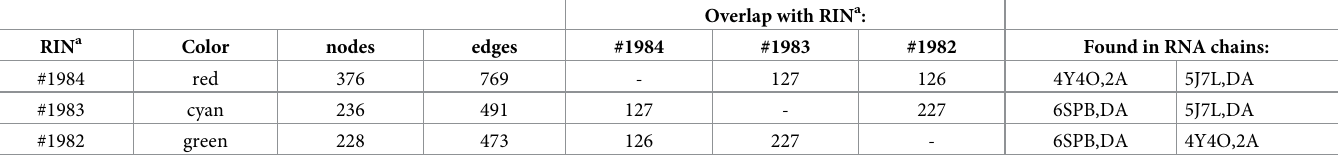
Table 7. Additional information on the 3 largest RIN a the number of nodes shared between the RIN a